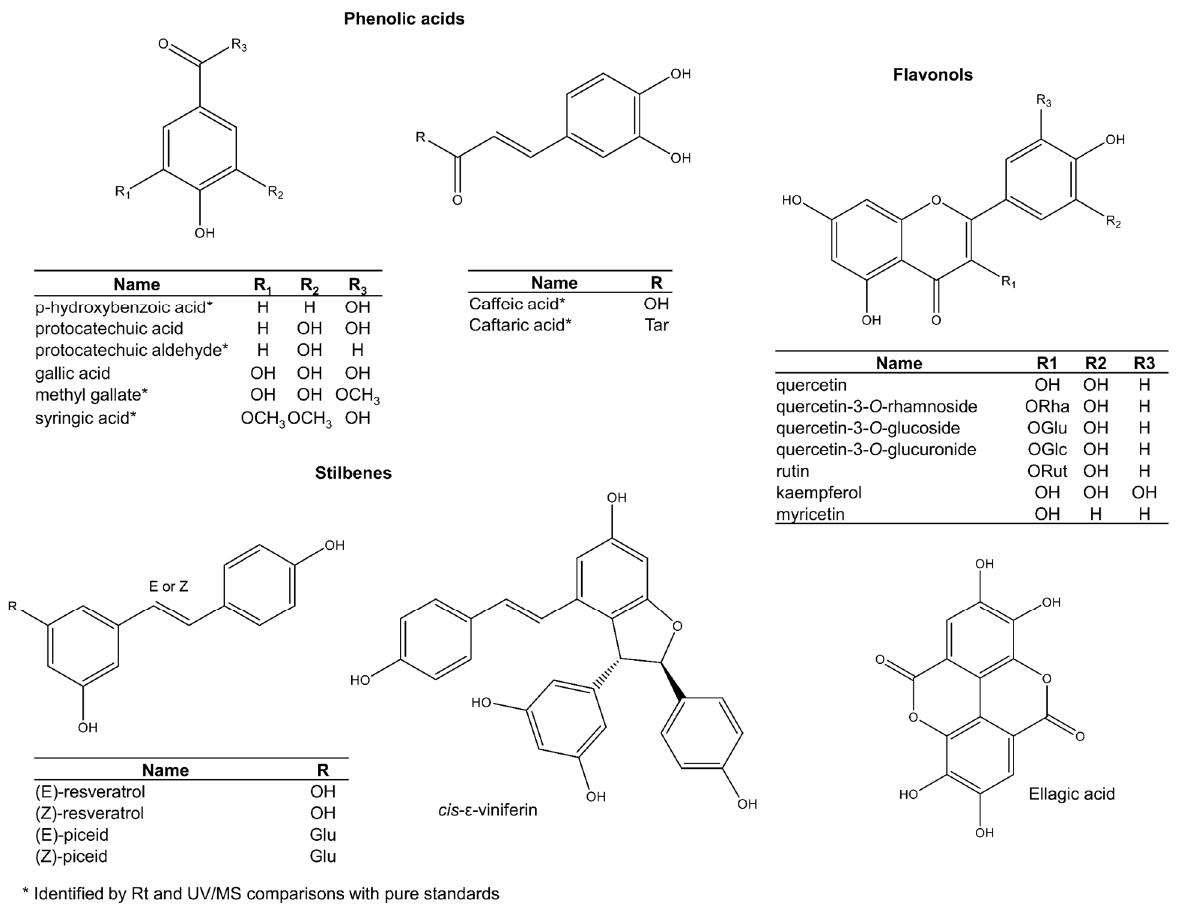
Figure 6. Other phenolic compounds reported in grape seeds.